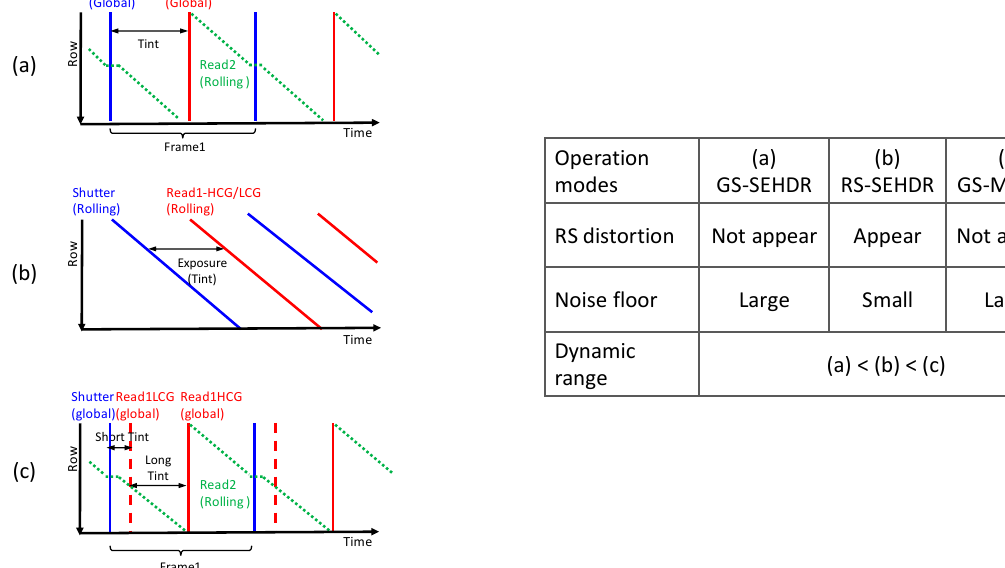
Figure 5. Shutter and readout timings for GS-SEHDR ( a ) RS-SEHDR; ( b ) and GS-MEHDR ( c ) mode.